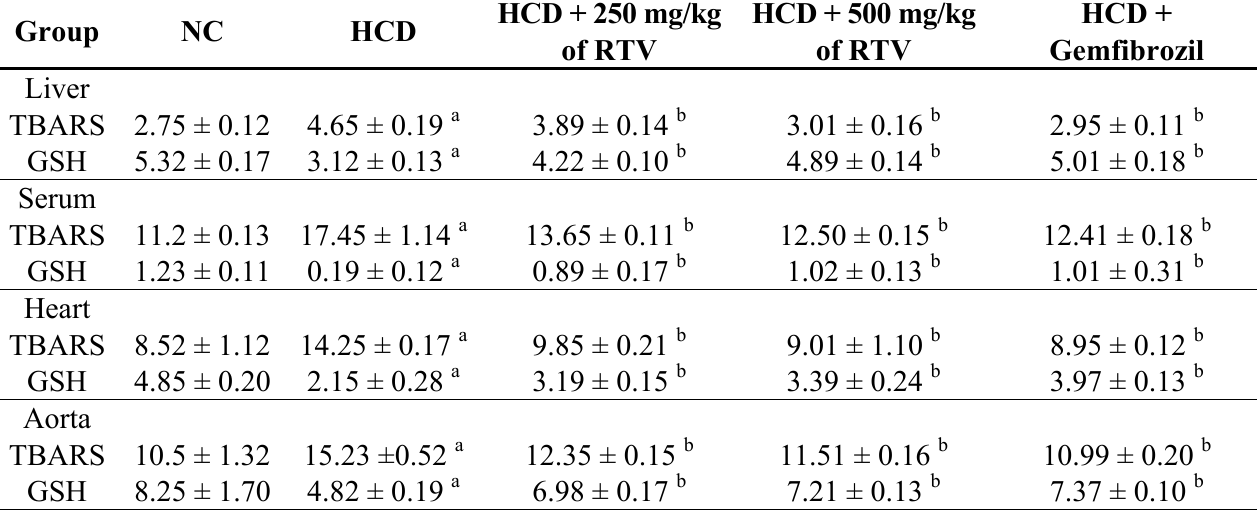
Table 2. Effects of crude extract of rhizomes of T. violacea on thiobarbituric acids (TBARS) and reduced glutathione (GSH) in tissues of rats kept on a high-cholesterol